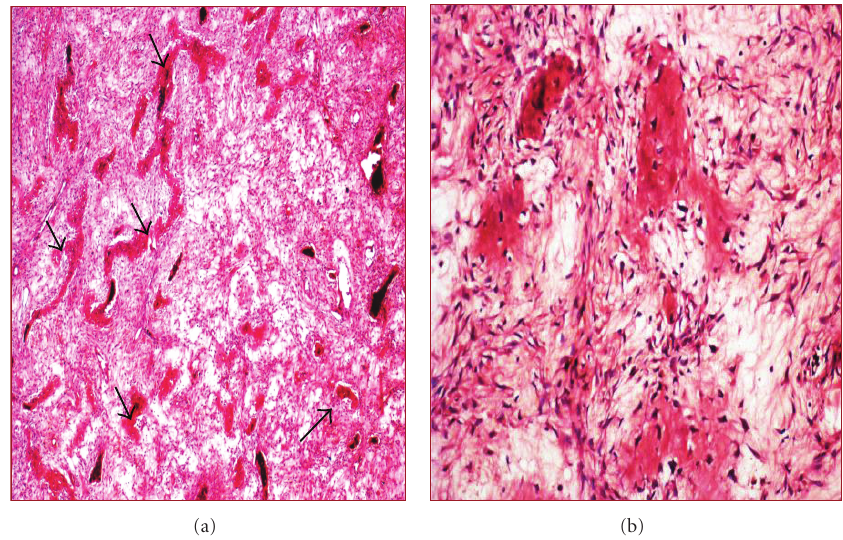
Figure 4: Microscopy, (a) “Chinese alphabet” spicules of woven bone (arrows) separated by abundant fibrous stroma (H&E, 20x). (b) No atypia of stromal cells (H&E,